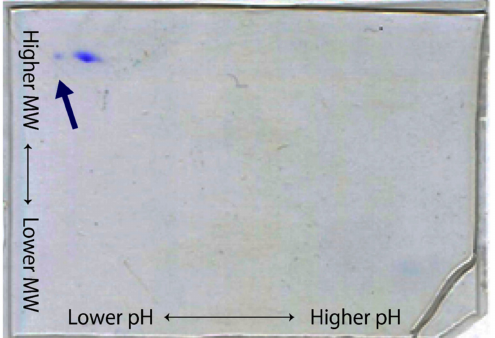
Figure 4. A two-dimensional electrophoresis analysis of an alpha-amylase. The protein sample is first separated by isoelectric focusing (IEF) and then separated by SDS-PAGE on a gel plate. Horizontal and vertical axes correspond to the pH and molecular weight, respectively. Auto 2D Plus, SHARP LIFE SCIENCE CO is used. With this sample, a crystal with a cluster-like morphology is frequently obtained with about a 1.4 Å resolution. After applying ionic exchange chromatography, a minor component (indicated by the blue arrow) was removed, and a single crystal with a 1.2 Å resolution was